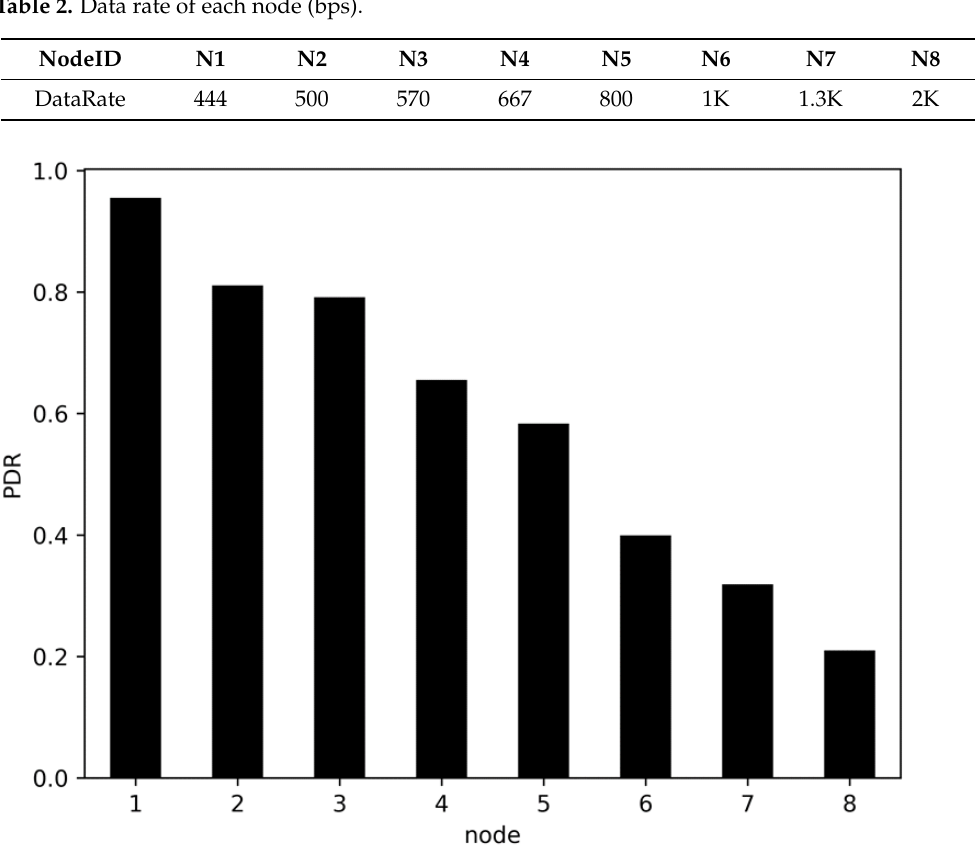
Figure 5. Packet Delivery Ratio (PDR) of each node in Tele-Medicine Protocol (TMP)